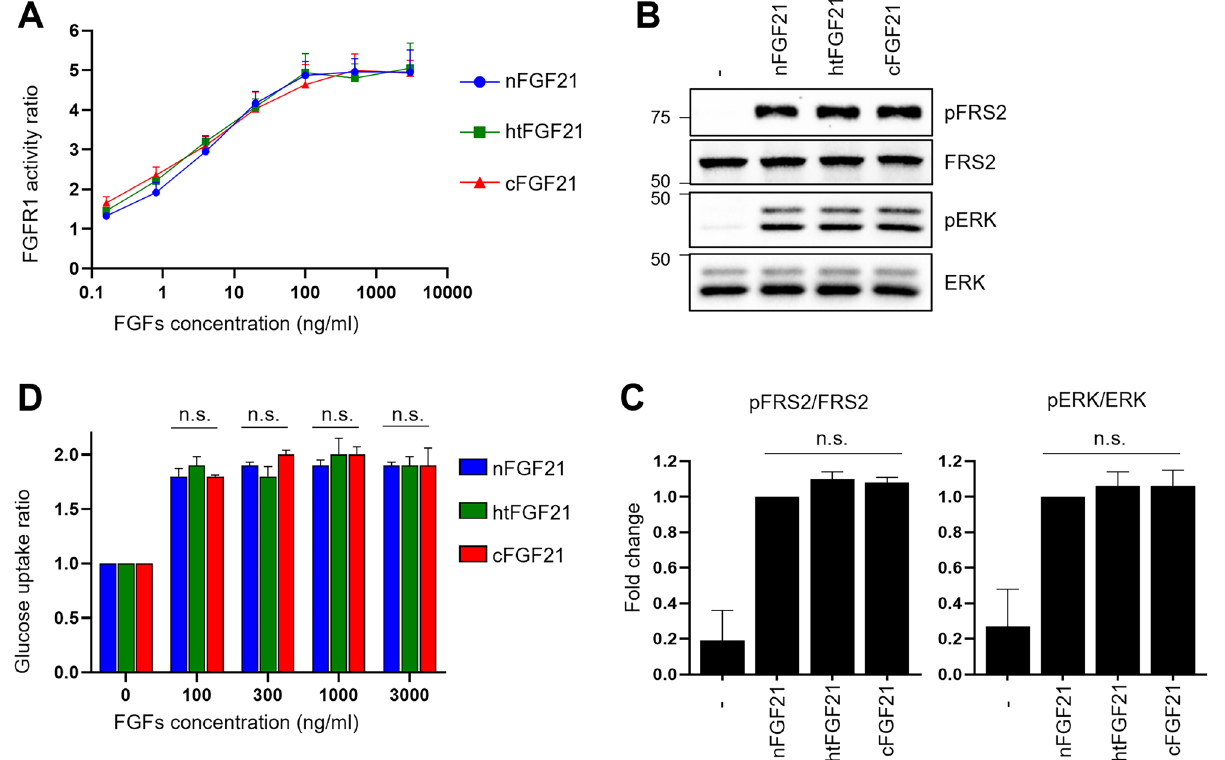
Figure 4. Cell-based activity tests of htFGF21. ( A ) Modified HEK293 cells used for reporting the FGFR1c/β- Klotho activity was treated with nFGF21, htFGF21, or cFGF21 at the indicated concentration for 6 h. Cell lysates were prepared for detection of luciferase activity. The levels of FGFR1c activity in non-treated cells were set to 1, and the other values were calculated relative to this value (n = 3, average ± SEM). ( B ) 3T3L1 adipocytes were treated with 100 ng/mL FGF21s for 15 min. Protein samples were prepared for western blotting. The original blots are presented in Supplementary Fig. S15. ( C ) The band density of nFGF21 treated cells was set to 1, and the other values were calculated relative to this value (n = 3, average ± SEM). ( D ) 3T3L1 adipocytes were treated with FGF21s at the indicated concentration for 6 h, followed by detection of glucose uptake levels. The glucose uptake values of non-treated cells were set to 1, and the other values were calculated relative to this value (n = 3, average ± SEM). The significance was evaluated using the one-way ANOVA, followed by Tukey’s post hoc test. n.s. not significant.